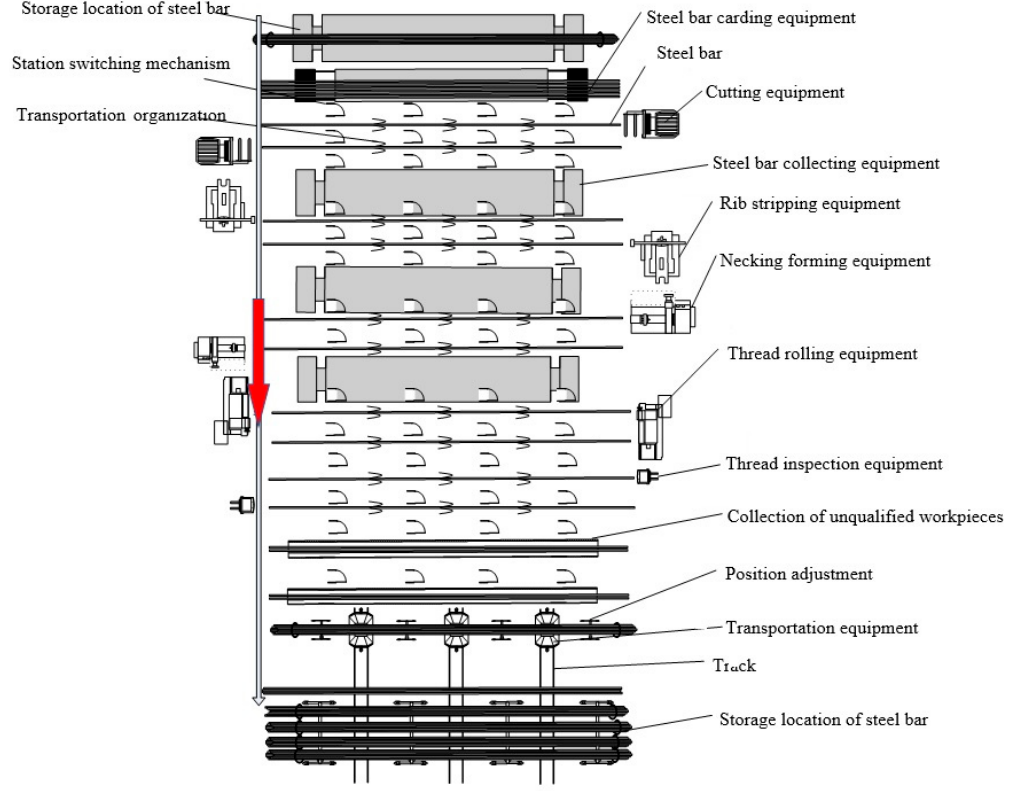
Figure 2. Layout of the HRB500 high-strength steel bars production line.